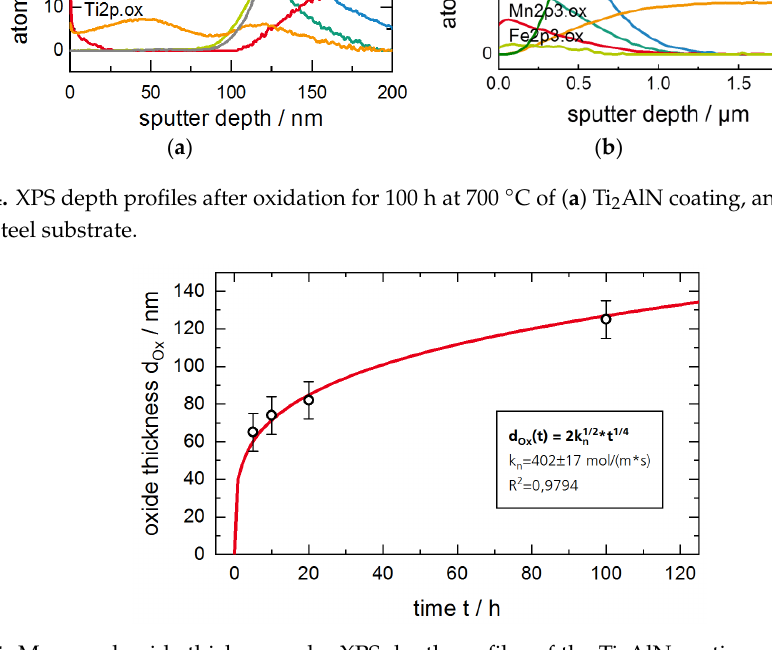
Figure 5. Measured oxide thicknesses by XPS depth profiles of the Ti 2 AlN coatings after oxidation. Underlying fit was performed using (1).